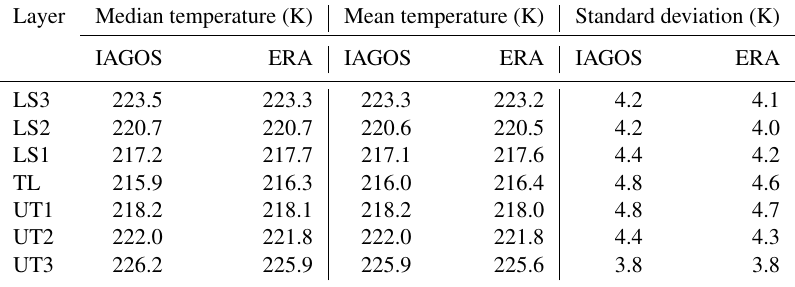
Table 2. Median, mean and standard deviation of temperature (K) for IAGOS and ERA data. The comparison shows very good